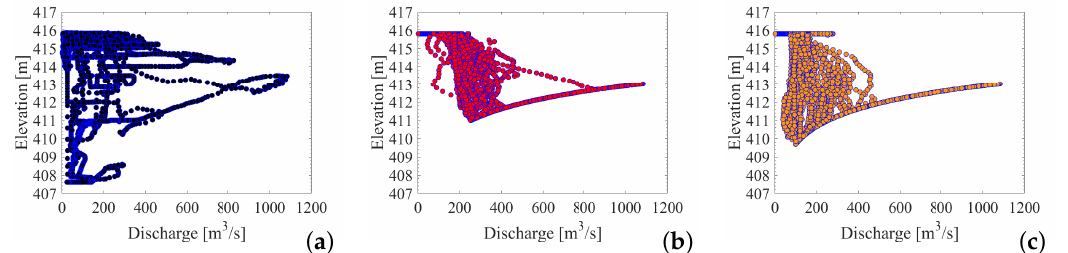
Figure 12. Stage-Discharge-relation for the three weir operating schemes: ( a ) observed; ( b ) draft; and ( c ) optimised.